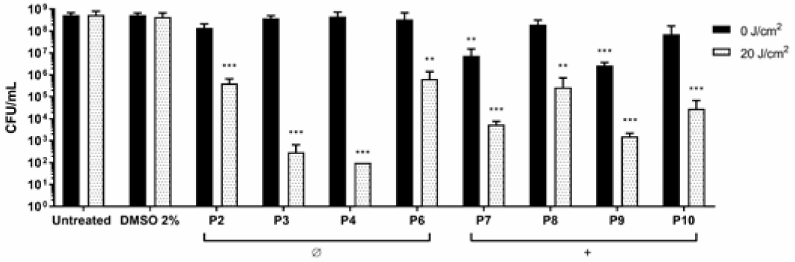
Figure 4. Photodynamic inactivation of S. aureus ATCC 6538P. After 1 h of dark incubation with P2 – 4, P6, and P7 – P10 at 10 µ M concentration, cells were irradiated under light at 410 nm at 20 J/cm 2 (grey bars) or kept in the dark (black bars). Values, presented as CFU/mL, are the mean of at least three independent experiments and the bars represent standard deviations. Statistical analyses using one-way ANOVA were performed between treated samples and reference untreated control (** p < 0.01; *** p <